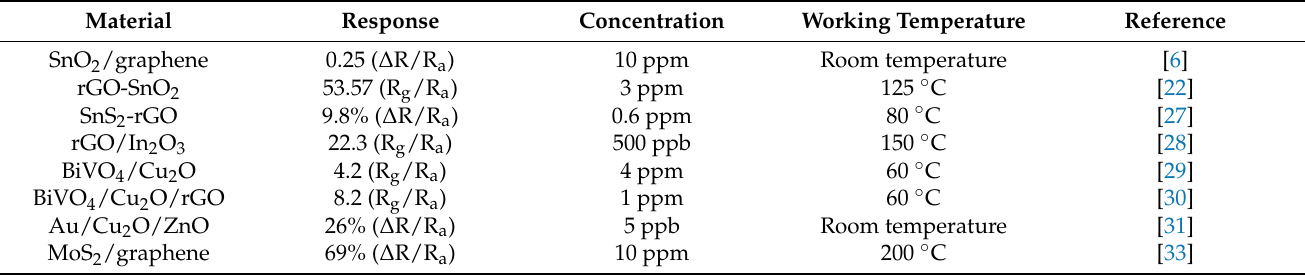
Table 1. The comparison of various NO 2 sensors based on rGO and Cu 2 O